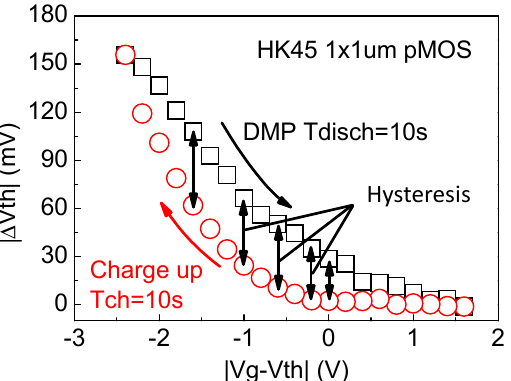
Figure 16. Presence of EADs: after charging, the electron energy level of the EADs rise, so that they cannot be discharged at the same energy level, resulting in the hysteresis [53].